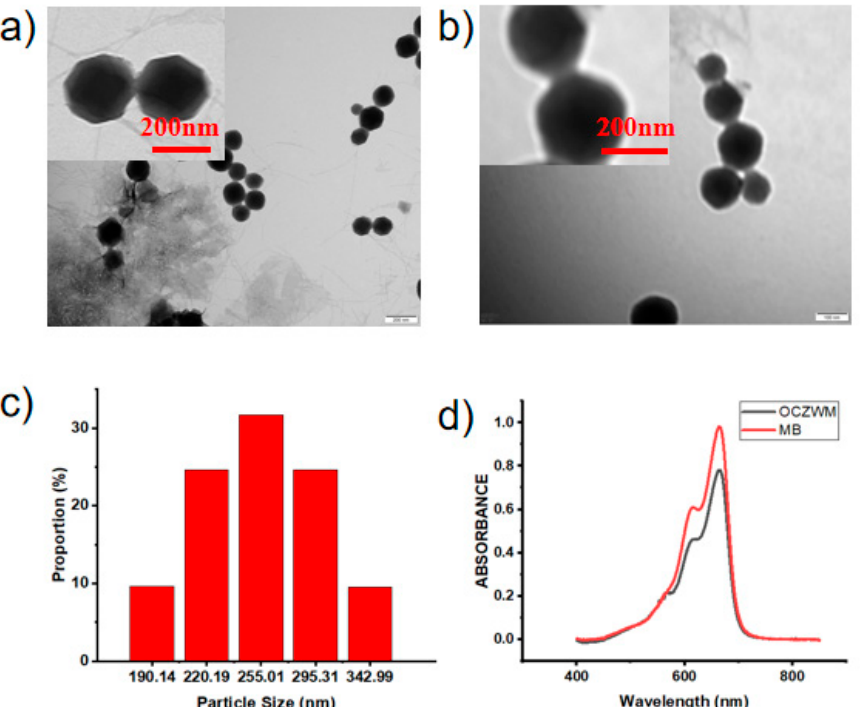
Figure 1. TEM images of ( a ) Cu/ZIF-8@ZIF-8 and ( b ) Cu/ZIF-8@ZIF-8@WP6–MB. The scale bar is 200 nm. Inset: partial enlarged images. The scale bar is 200 nm. ( c ) DLS data of Cu/ZIF-8@ZIF-8@WP6–MB. ( d ) UV-Vis spectra of Cu/ZIF-8@ZIF-8@WP6–MB and MB aqueous solution at room temperature.